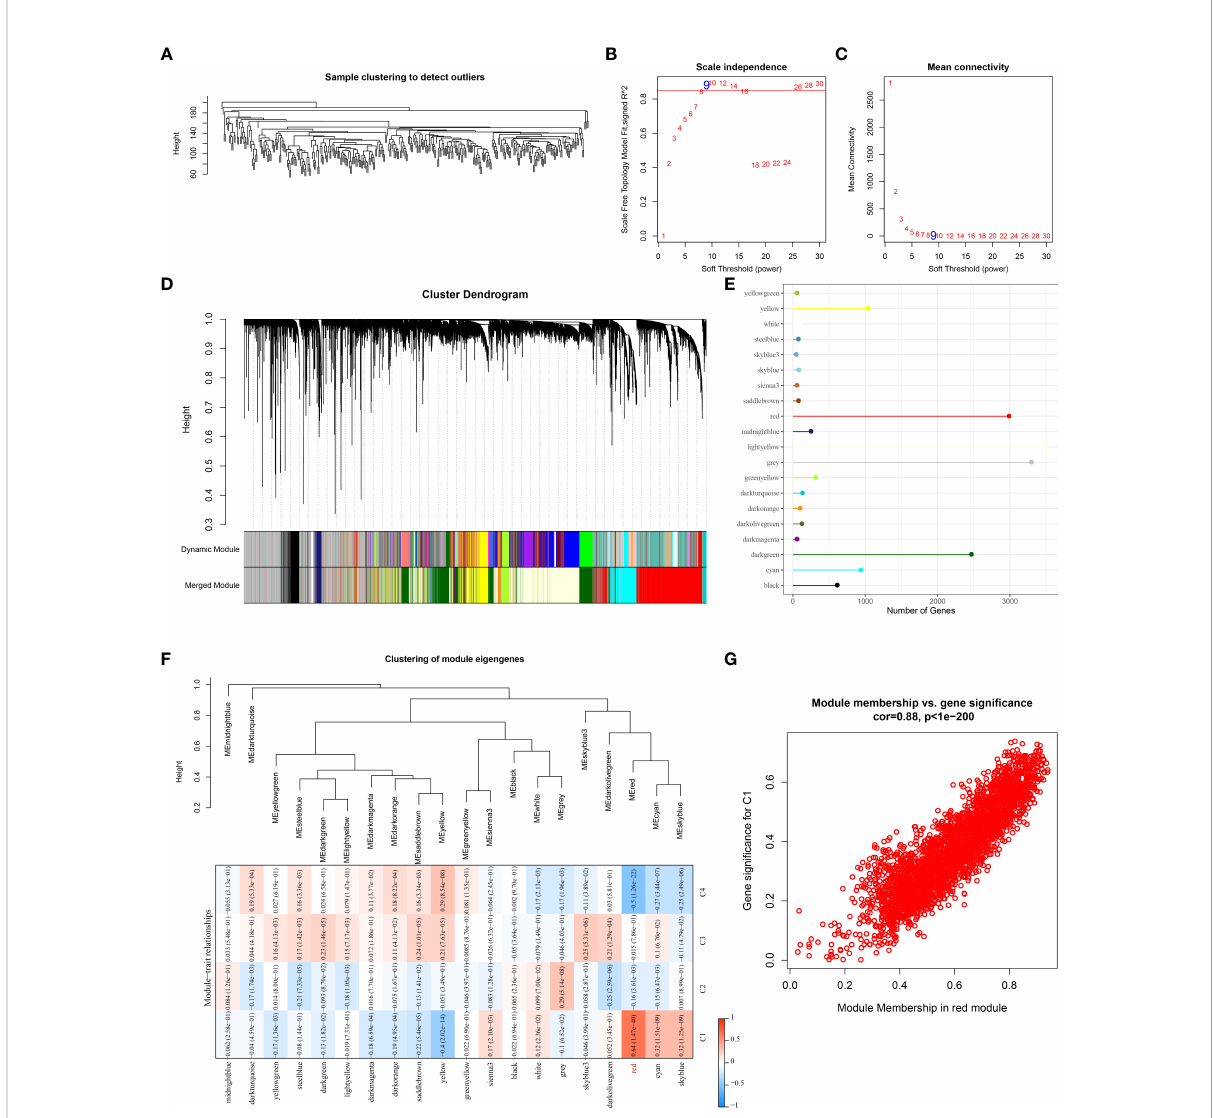
FIGURE 5 Identi fi cation of gene modules that associated with molecular subtyps by WGCNA analysis in the TCGA cohort. (A) Cluster analysis of samples of STAD in the TCGA cohort; (B) Analysis of the scale-free fi t index for various soft-thresholding powers ( b ) ; (C) Analysis of the mean connectivity for various soft-thresholding powers. (D) Hierarchical clustering dendrogram of co-expressed genes in modules in STAD; (E) The number of genes in each gene module; (F) Correlation between the module eigenvectors of each module and molecular subtypes; (G) Scatter diagram for module membership vs. gene signi fi cance for C1 subtype in the red